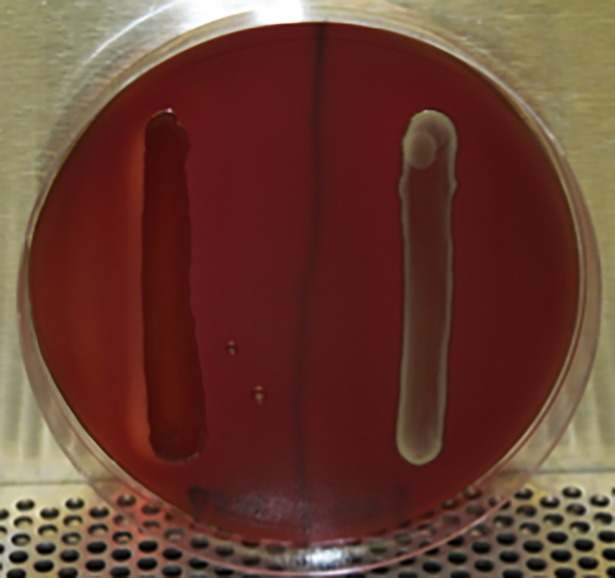
W83Δ514 hyperpigmentation on whole blood BAP.Overnight broth cultures streaked on modified BAP containing whole (non-lysed) blood after 3-day incubation (Left W83Δ514, Right W83).